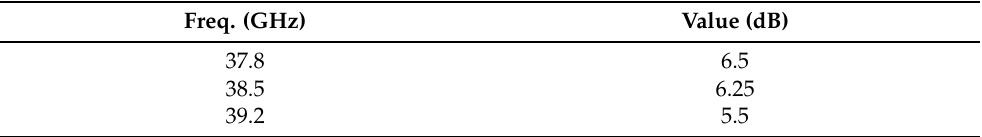
Figure 10. Gain and radiation efficiency of the proposed antenna system. Table 2. Measured gain of the proposed